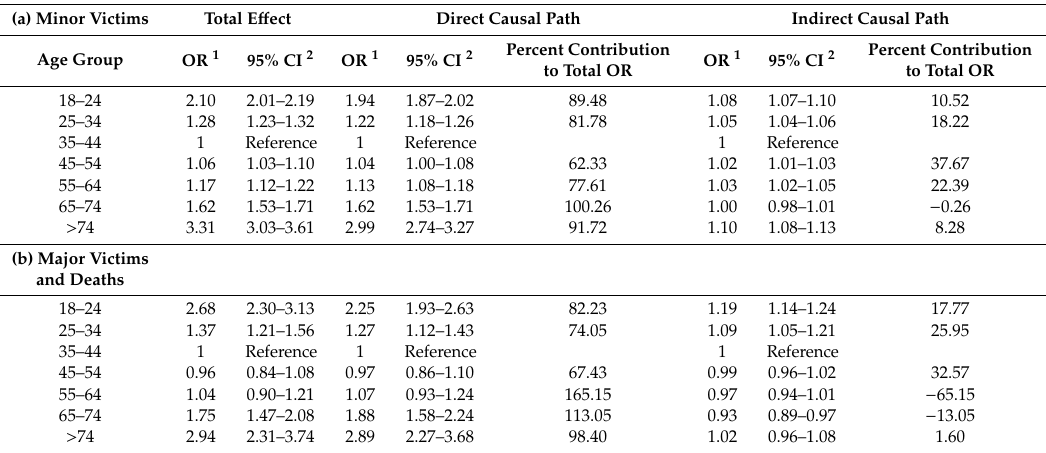
Table 3. Total OR, Direct Causal Path OR and Indirect Causal Path OR to estimate the association between each age group of drivers and the odds of causing a road crash stratified by severity of the